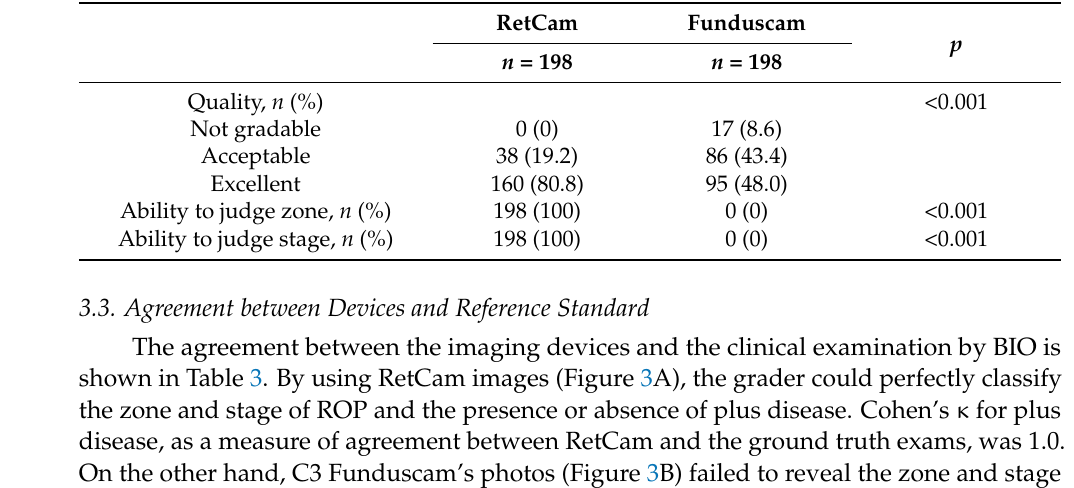
Table 2. Image gradeability between the RetCam and smartphone-assisted devices ( n = 198 in each modality).